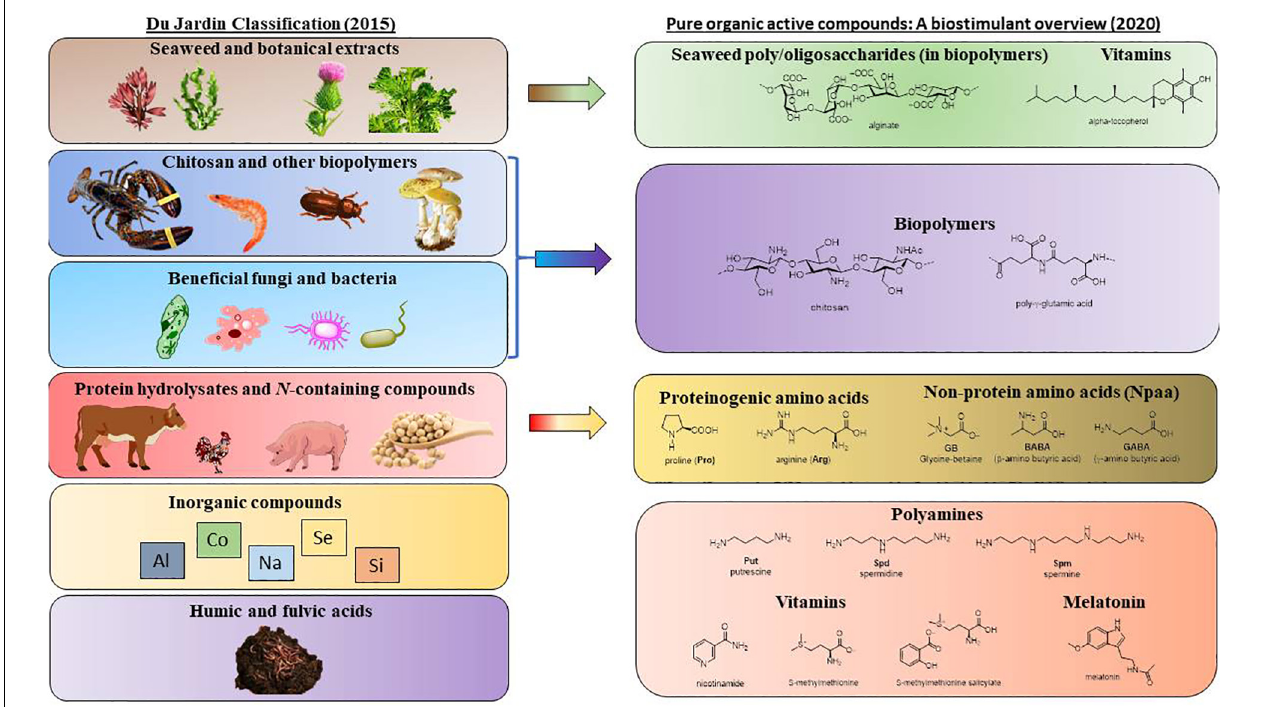
FIGURE 2 | Pure organic active compounds and their relationship with biostimulants classified by du Jardin